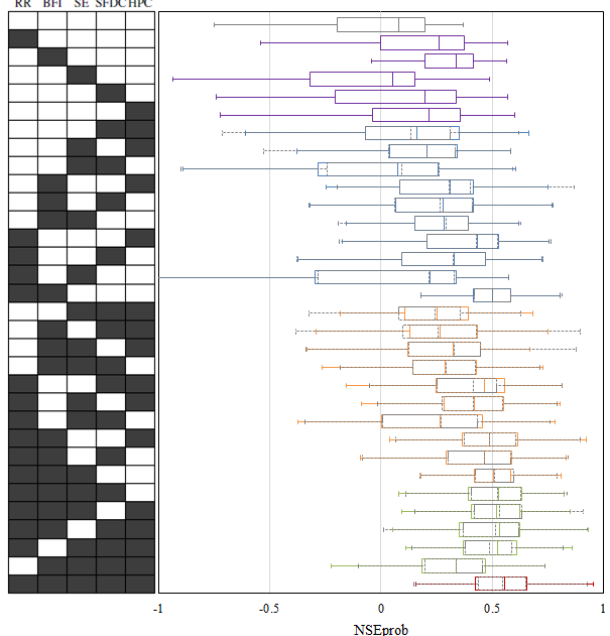
Figure 4. Boxplots representing the distribution of NSEprob values for each combination of signatures for synthetic streamflow data. The colored boxplots correspond to the results obtained when inter- signature error correlations are considered in the likelihood func- tion, whereas the grey dashed boxplots correspond to the results obtained assuming that the inter-signature errors are independent.